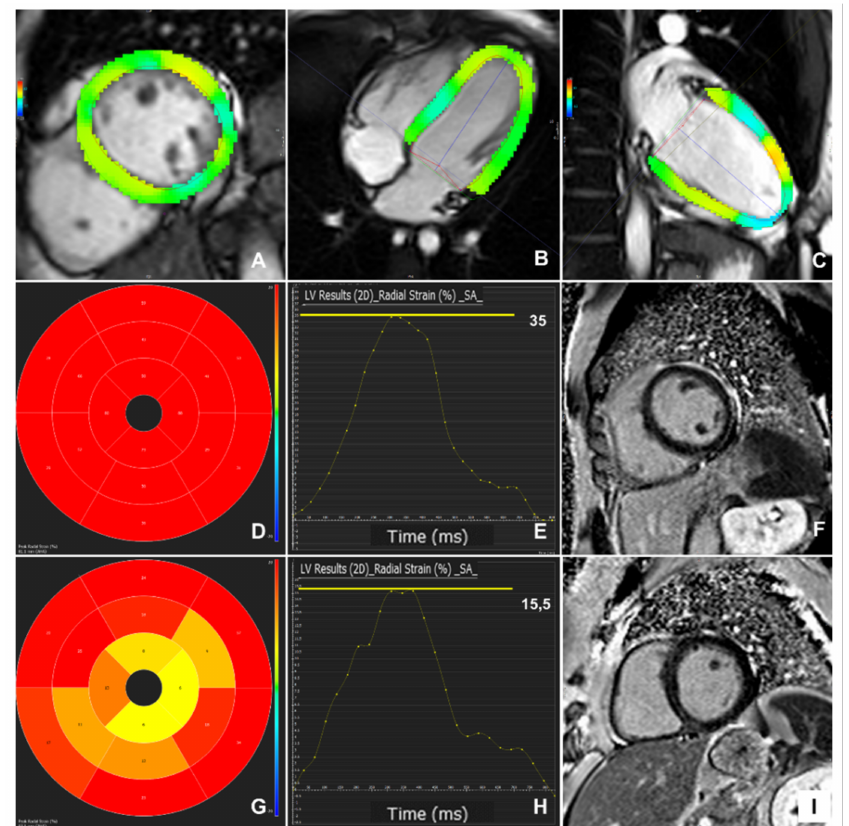
Figure 2. Feature-tracking CMR 2D left ventricular coloured strain analysis on short-axis ( A ) and long-axes ( B , C ) SSFP images. Normal peak radial strain 16-segment map ( D ) and strain curve ( E ) from a patient with normal CMR findings and no enhancement on late gadolinium imaging ( F ); impaired peak radial strain 16-segment map ( G ) and strain curve ( H ) in a patient with an enhancement pattern on late gadolinium imaging in keeping with previous myocarditis ( I ).